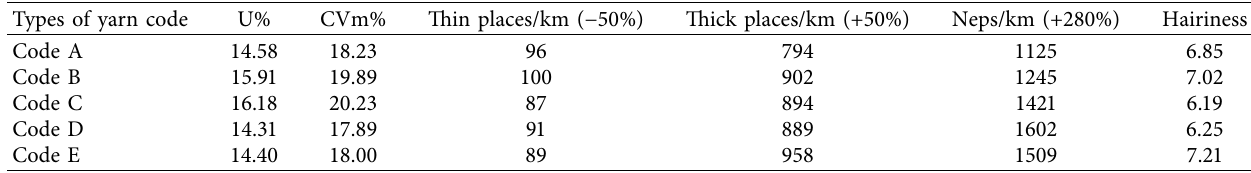
Figure 3: Testing equipment. Table 2: USTER statistics of yarn evenness.